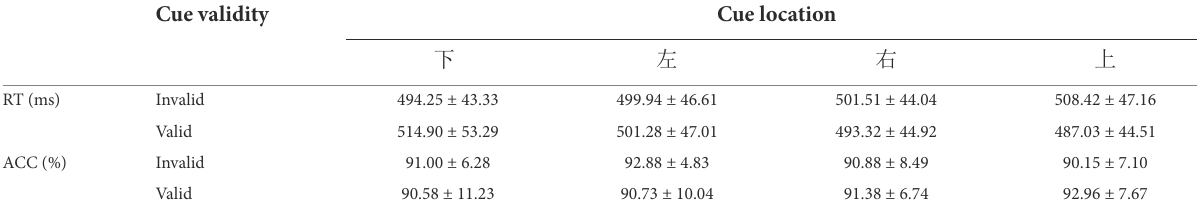
TABLE 4 The average response times and accuracy rates of the combinations of cue validity and cue location in Experiment 3 (M ±